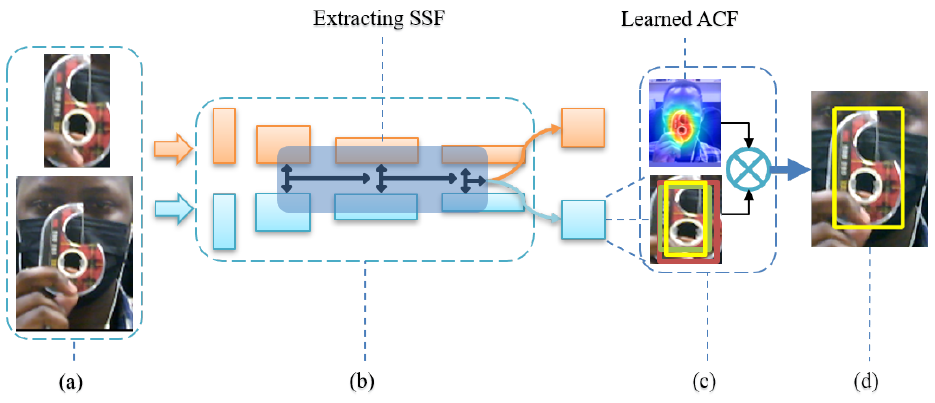
Figure 2. Spatially semantic correlation features (SNS-CF) proposed algorithm: ( a ) A pair of input images and the corresponding search window, ( b ) the Siamese network with three region proposal networks in a shadowed middle part, which highlights spatially semantic correlation features of interest, ( c ) the correlation search module, with multiple up-sampled bounding boxes convolved with a learned adaptive correlation filter (ACF), and ( d ) output of the predicted final tracking result with a yellow bounding